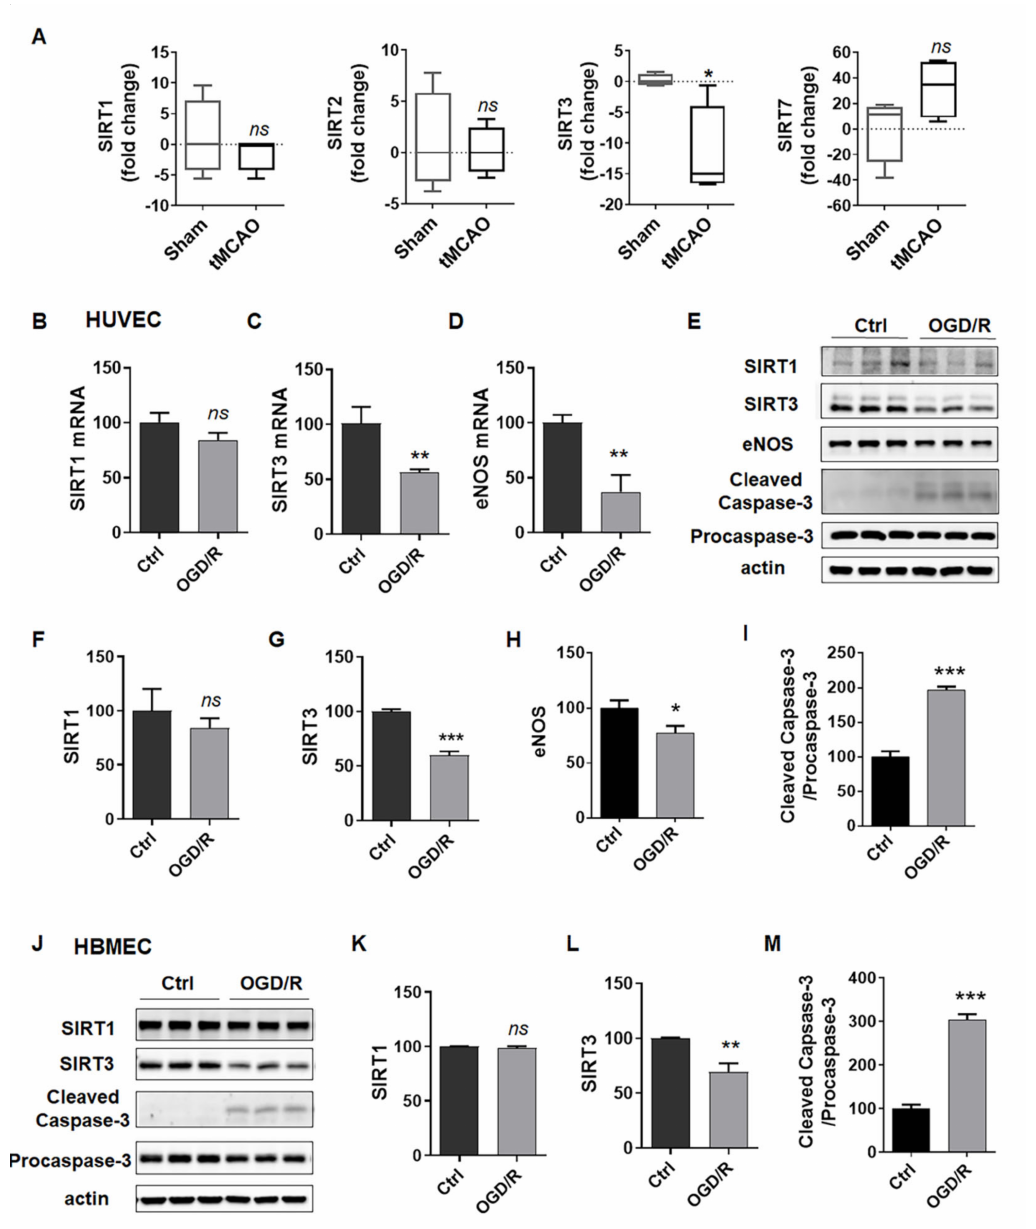
Figure 2. SIRT3 expression is reduced in ECs after exposure to OGD/R. ( A ) SIRT1, SIRT2, SIRT3 and SIRT7 mRNA levels in the brain cortex of the SD rats following tMCAO or the sham-operated controls from published GSE38037. ( B – D ) mRNA levels of SIRT1, SIRT3 and eNOS in HUVECs treated with or without OGD4h/R24h. ( E – I ) Protein levels of SIRT1, SIRT3, eNOS, cleaved caspase-3 and procaspase-3 in HUVECs treated with or without OGD4h/R24h. ( J – M ) Protein levels of SIRT1, SIRT3, cleaved caspase-3 and procaspase-3 in HBMECs treated with or without OGD6h/R24h. eNOS, endothelial nitric oxide synthase. The data are presented as the means ± SD, and were assessed using t test. * p < 0.05 vs. the Ctrl group or sham group, ** p < 0.01 vs. the Ctrl group, *** p < 0.001 vs. the Ctrl group. ns, no significance. n = 3 for